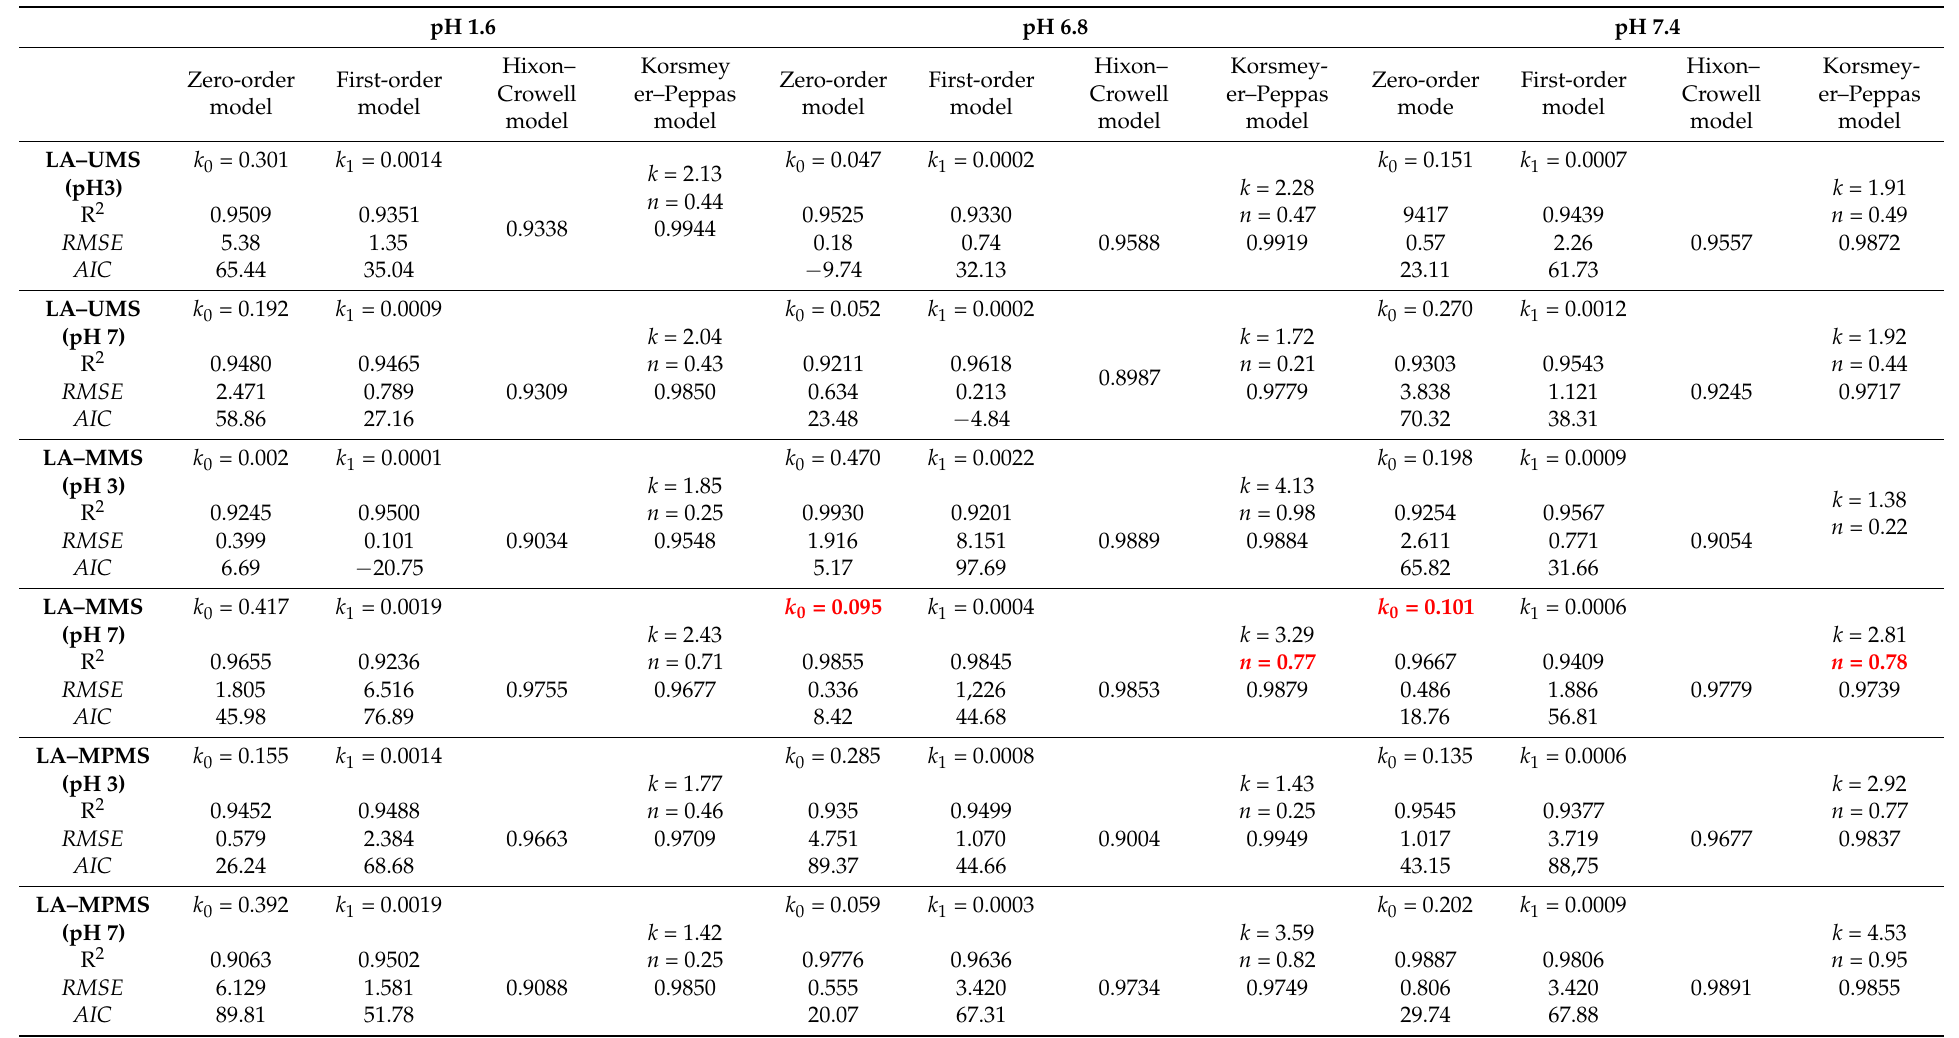
Table 4. Model parameters of LA and LM release from LA–silica and LM–silica composites in different release media (The estimated uncertainty in n is